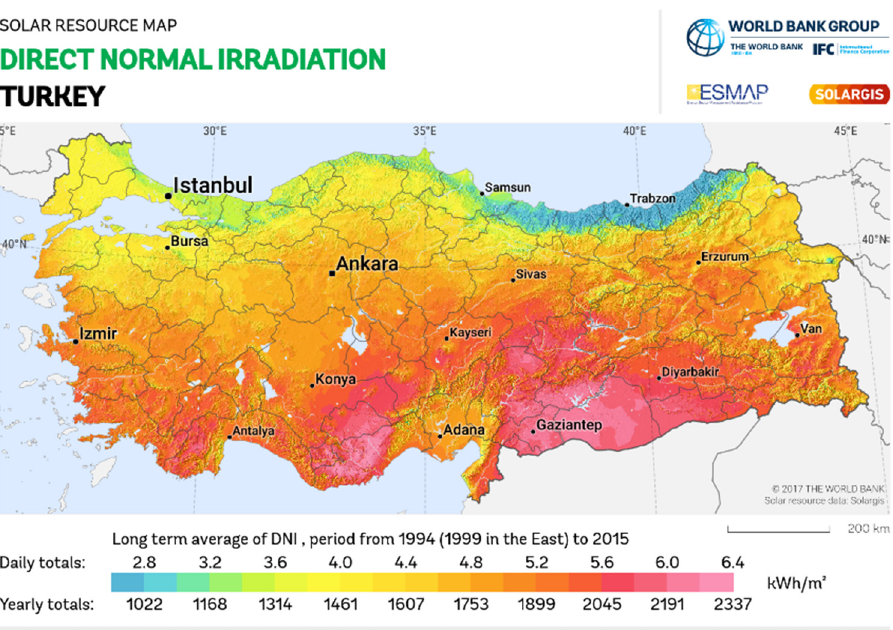
Figure 1. Solar energy map of Turkey.